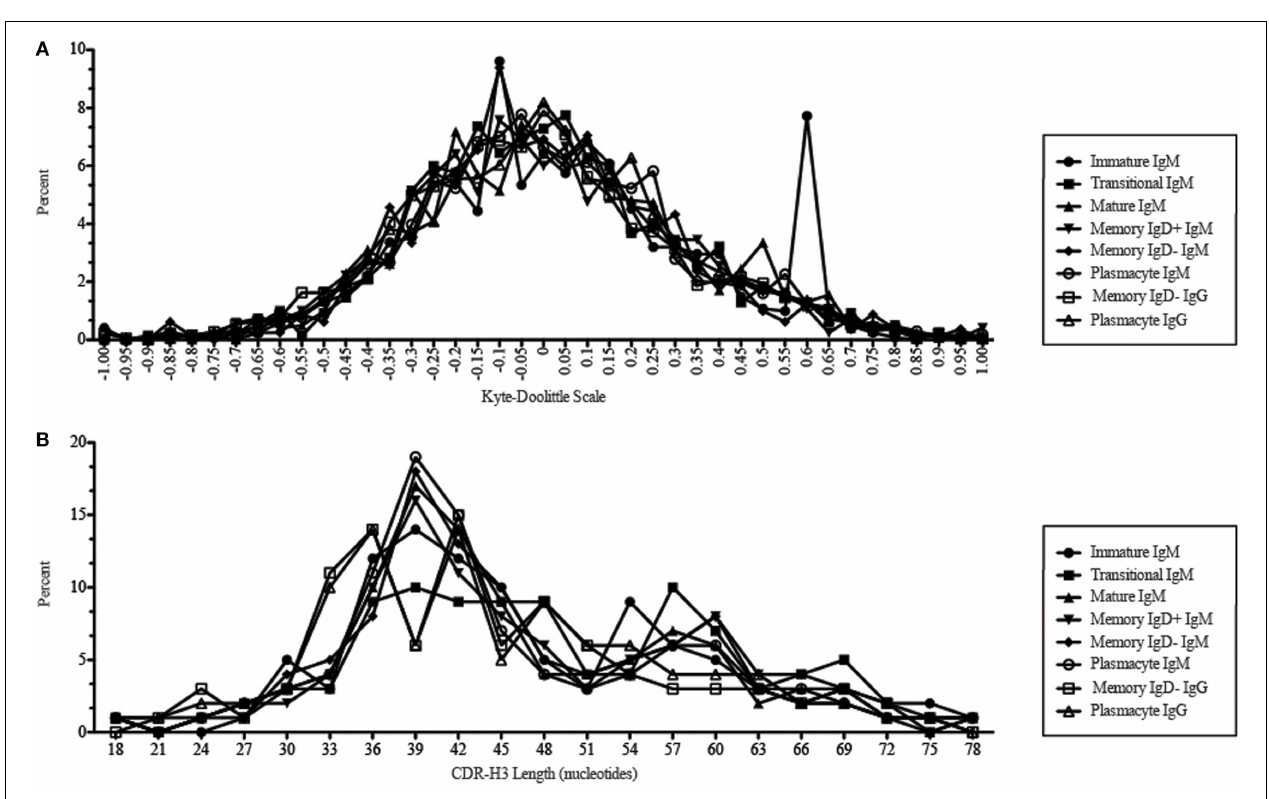
hydrophobicity (30). Although this scale ranges from − 1.3 to + 1.7, only the range from –1.0 (charged) to + 1.0 (hydrophobic) is shown. Prevalence is reported as the percent of the sequenced population of unique, in-frame, open transcripts from each B lineage fraction. (B) Distribution of CDR-H3 lengths in nucleotides of µ and γ H chain transcripts is